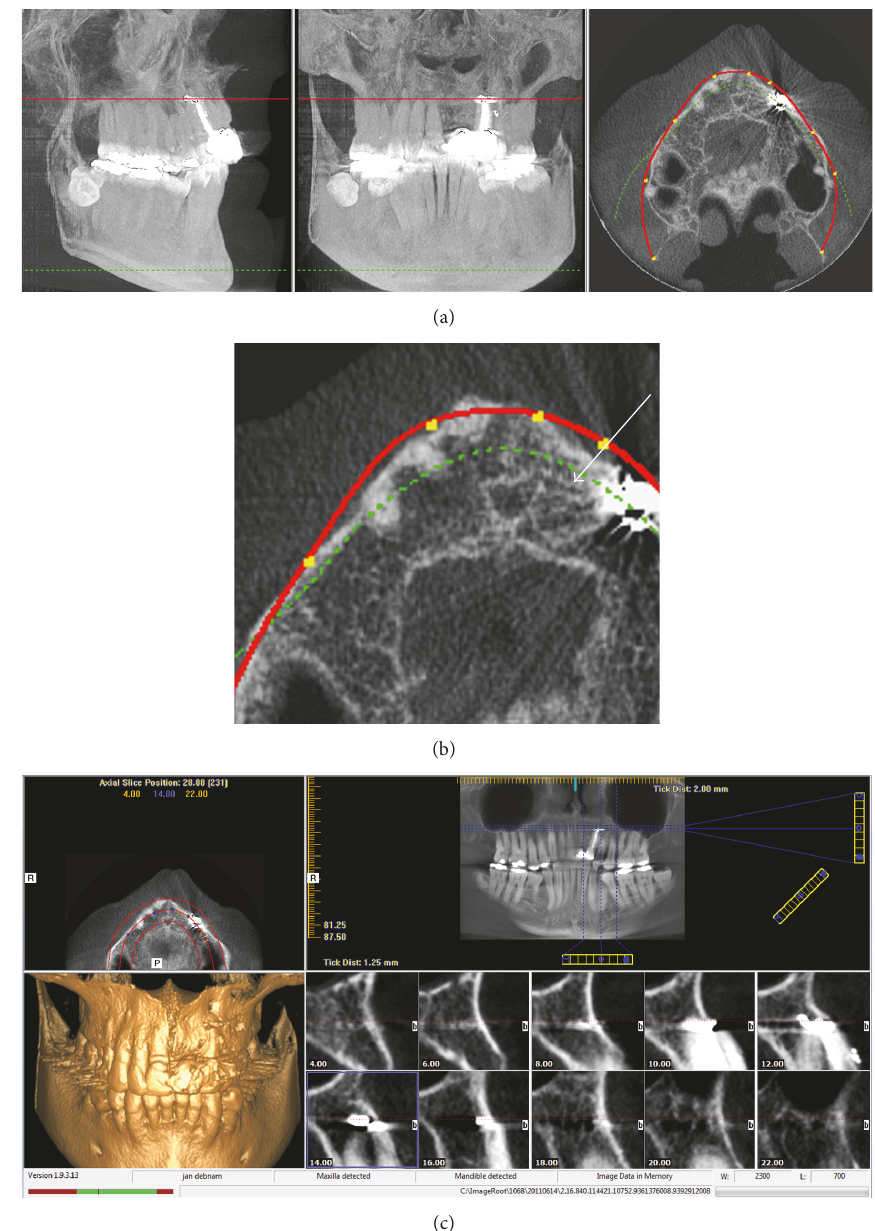
Figure 5: (a) CBCT (iCAT) imagery taken during original implant assessment by implant clinic. (b) Magnified axial image from (a) showing that a well-demarcated canal is present between the apex of tooth 23 and the nasopalatine canal, white arrow. (c) Multiple foramina are easily seen throughout the apical/nasal region prior to implant